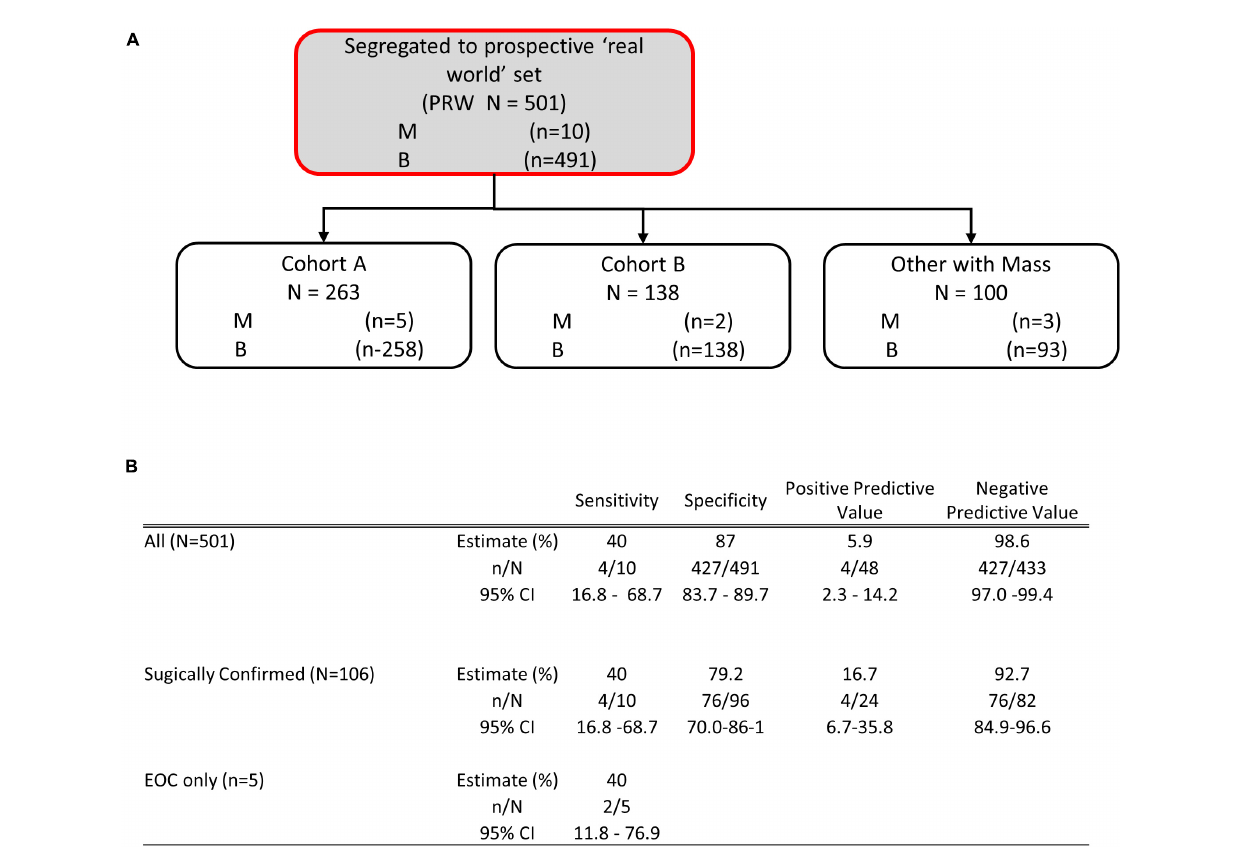
FIGURE6 Performance of OVAWatch in the prospective real-world (PRW) study. (A) Flow diagram showing patient data represented (shaded, with red outline). The inset Table (B) shows the performance for all patients, only those who went to surgery and sensitivity for EOC malignancies.